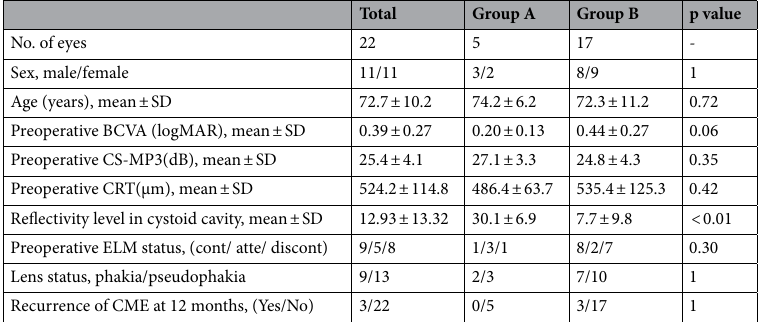
Table 1. Patient demographics. SD standard deviation, DR diabetic retinopathy, RVO retinal vein occlusion, CRT central retinal thickness, BCVA best-corrected visual acuity, logMAR the logarithm of the minimum angle of resolution, CS central sensitivity, MP microperimetry, ELM external limiting membrane, cont continuous, ate attenuation, discount discontinuous, CME cystoid macular edema.